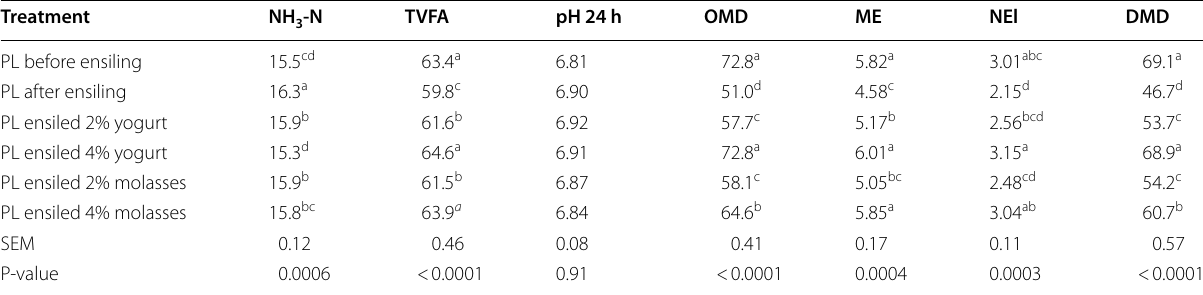
Table 5 Some ruminal fermentation parameters measured in the culture medium after incubation of fresh pomegranate leaves or ensiled with different additives